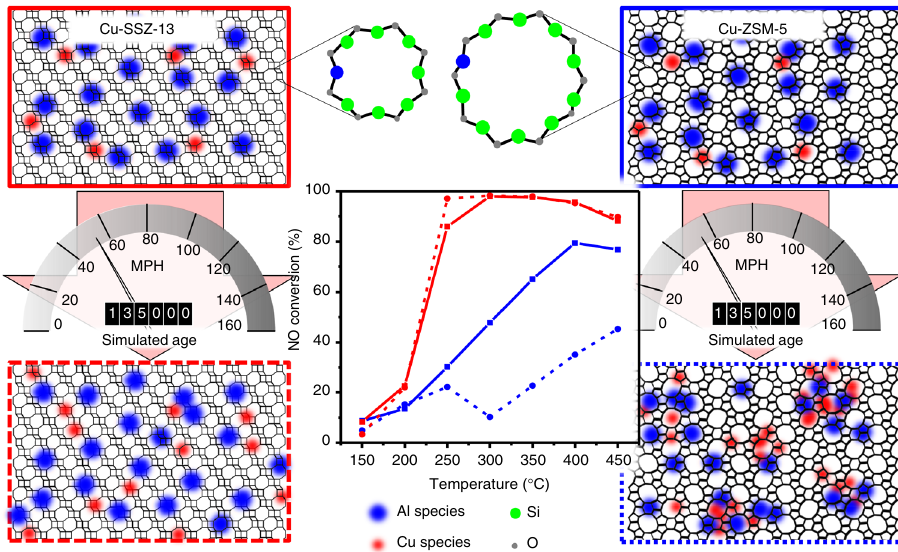
Fig. 1 Reaction testing and overview of experimental fi ndings. The center graph shows the NO conversion for the ammonia selective catalytic reduction (NH 3 -SCR) reaction testing results for the four Cu-exchanged zeolite materials under study, the traces correspond to the borders of the four schematics. The feed consists of 1000 ppm NO, 1000 ppm NH 3 , 5% O 2 , balanced by He. The data have been measured in steady-state mode (GHSV = 100,000 h − 1 ). The panels at the corners give a 2D schematic overview of the results of this study with regards to the distribution of Al and Cu in Cu-SSZ-13 and Cu-ZSM- 5, which are distributed slightly heterogeneously in fresh Cu-SSZ-13 and Cu-ZSM-5. After the simulated 135,000 mile aging procedure the Cu in Cu-SSZ-13 is found to migrate somewhat, as the schematic shows, though the material still retains good catalytic activity. In Cu-ZSM-5, the simulated aging causes signi fi cant migration of Cu and Al into stoichiometric copper aluminate species. One of the signi fi cant reasons that Cu-ZSM-5 is more damaged is that both Cu and Al species are able to migrate through its larger rings, whereas the small rings in Cu-SSZ-13 prevent Al migration, limiting damage to the